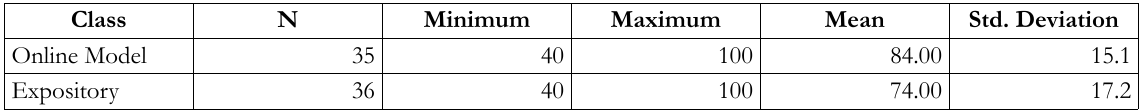
Table 1. The Mathematic connection skill of Both Classes